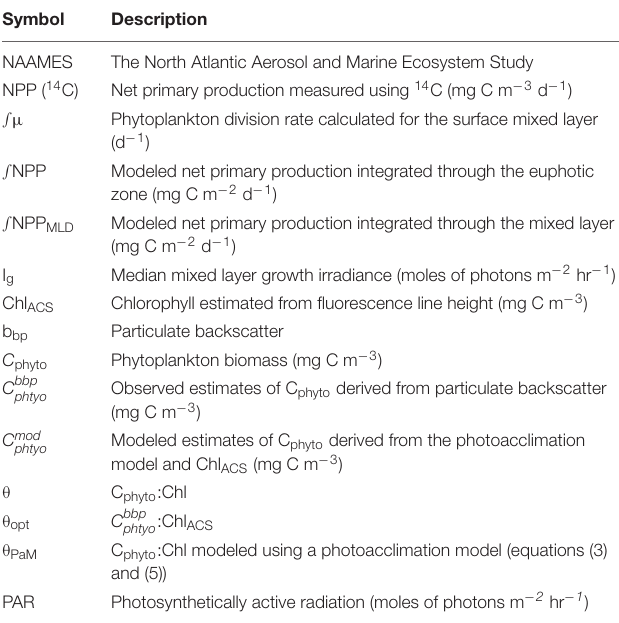
TABLE 1 | Symbols, terms, definitions and units.